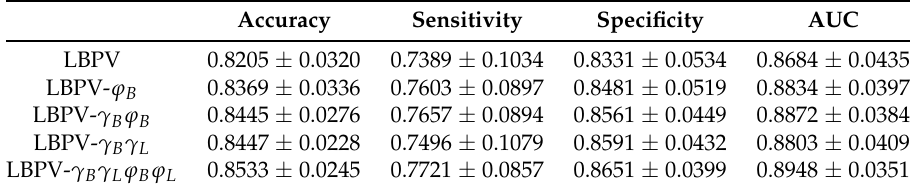
Table 2. AUC, accuracy, sensitivity and specificity related to the exudate detection for E-OPHTHA exudates database taking into account different input vectors to the SVM classifier. In particular, they are composed by texture and shape descriptors.